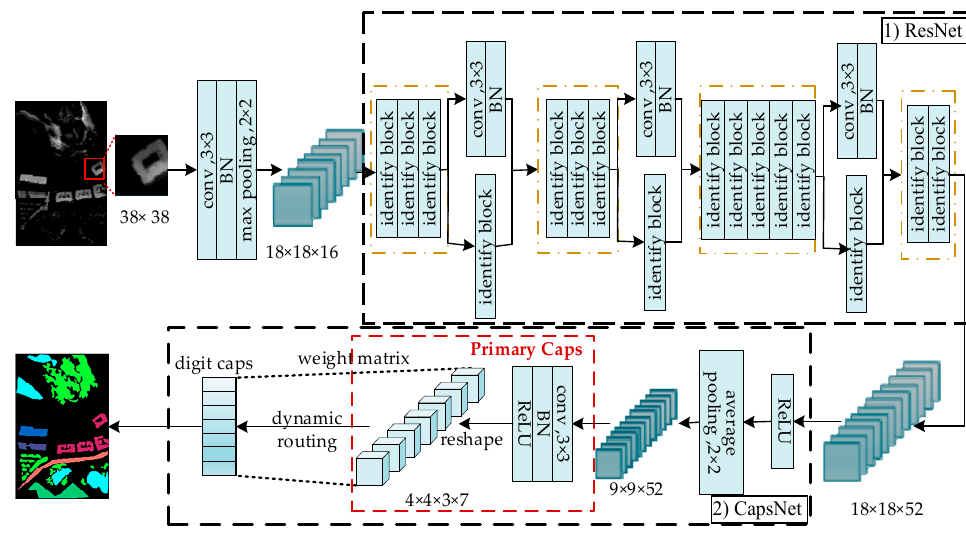
Figure 3. Architecture of the proposed method. The proposed architecture is composed of two